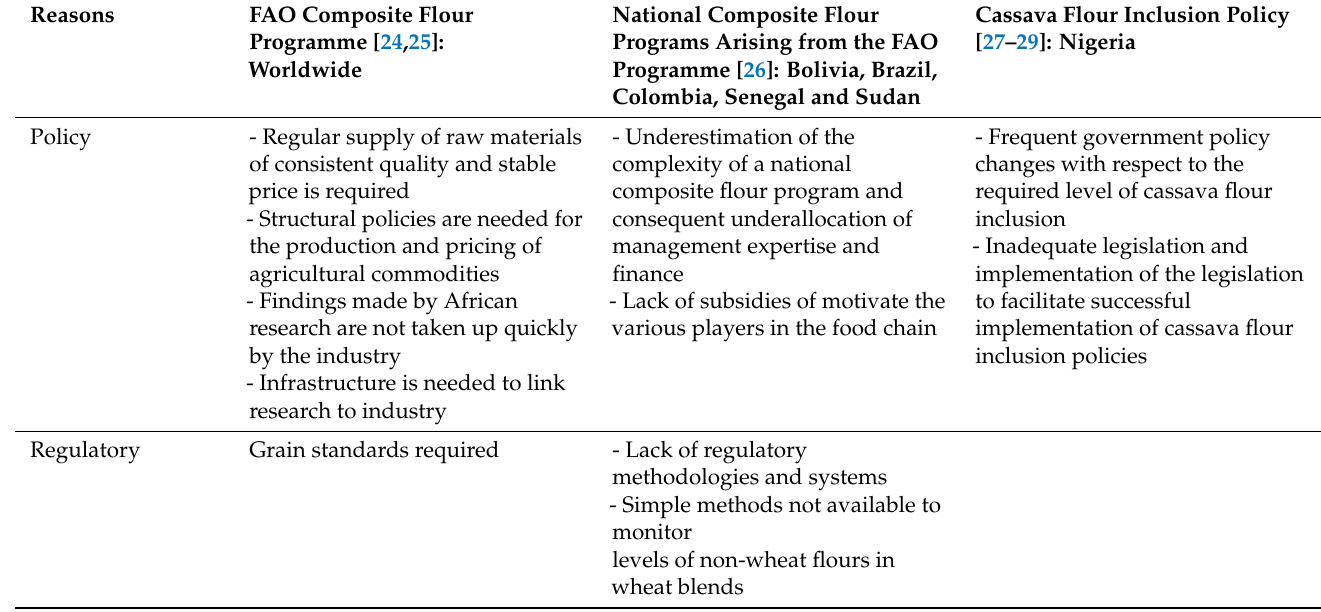
Table 1. Reasons proposed for the lack of success and limited impact of wheat flour replacement